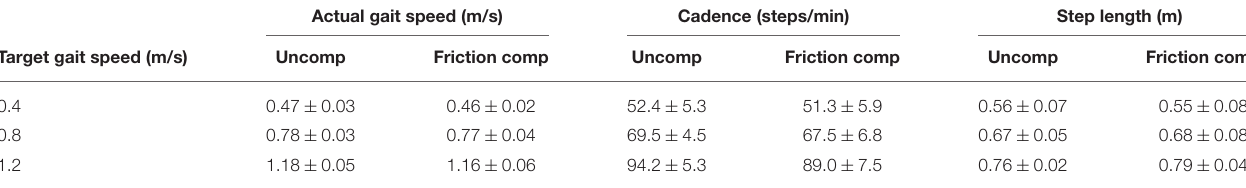
TABLE 2 | Average gait speed, cadence, and normalized step length for each target speed and condition.